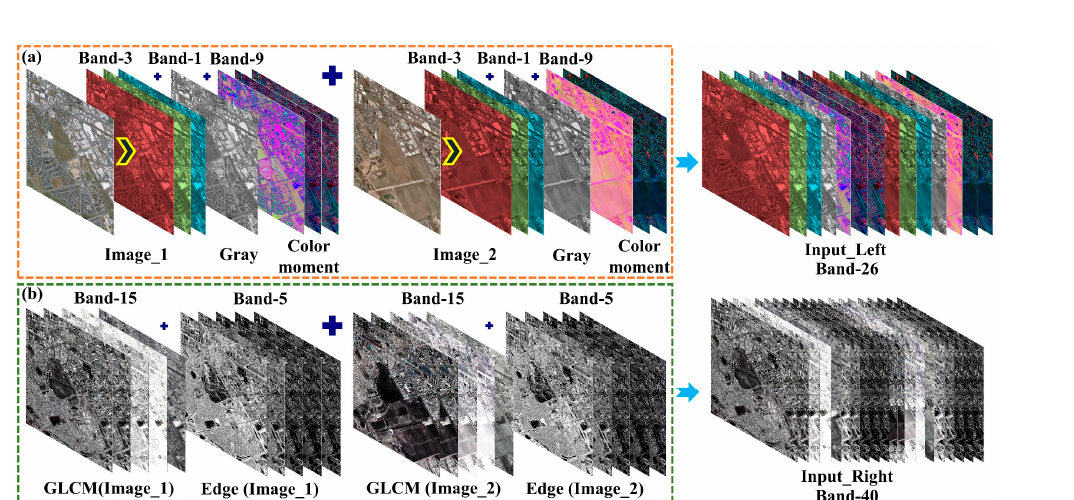
Figure 4. Schematic diagram of feature combinations. ( a ) Input on the left side of the network. ( b ) Input on the right side of the